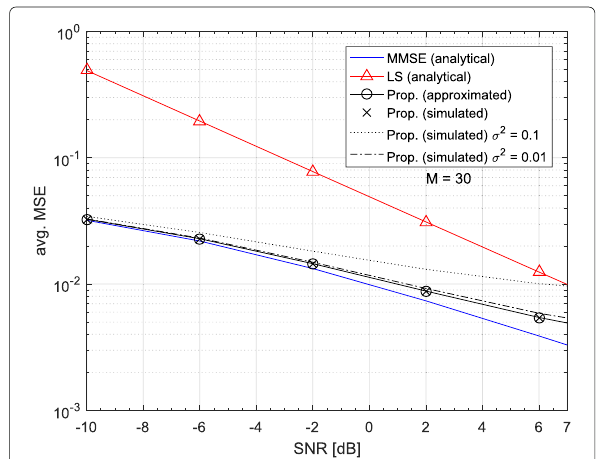
Fig. 6 Average channel estimation MSE under random { β ilk }